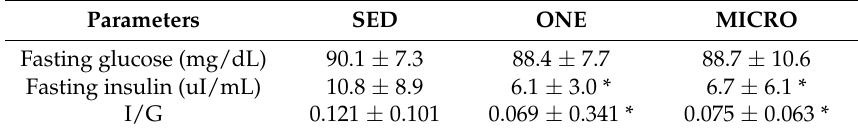
Table 3. Fasting plasma glucose and insulin concentrations.